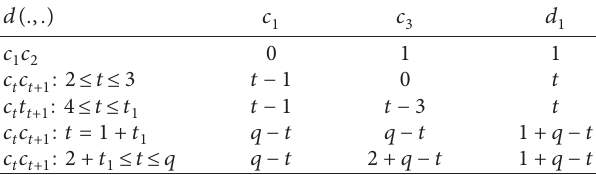
Figure 2: G � P □ P . 5 6 Table 1: Codes of outer edges of GP ( q, 1 ) when q is odd. d ( ., . )